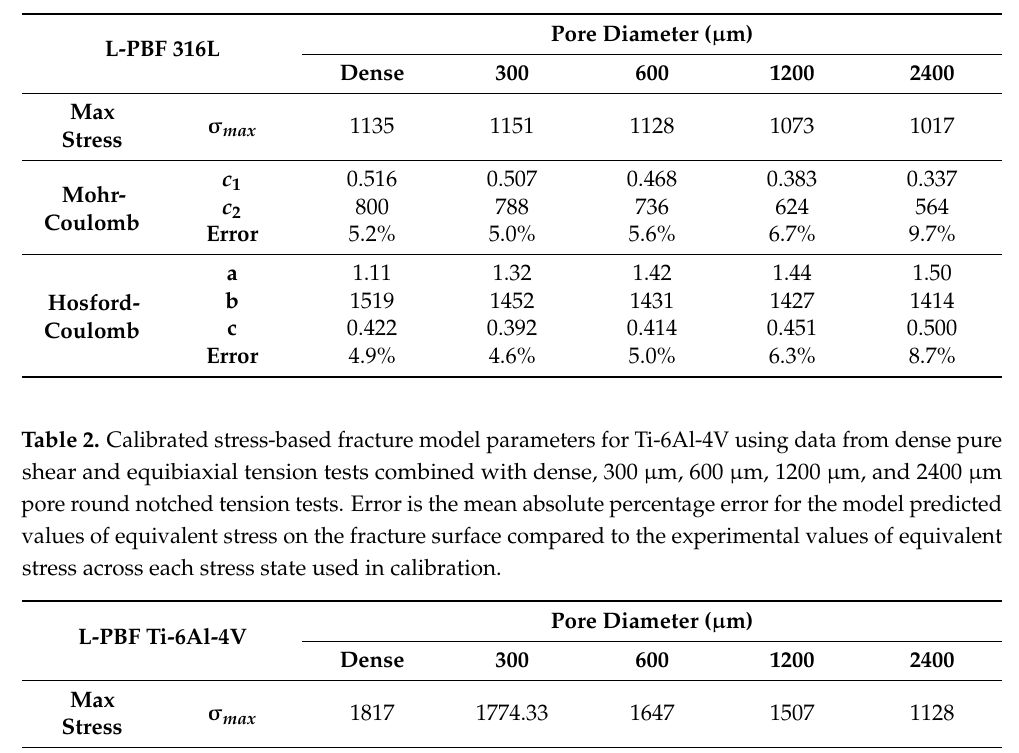
Table 1. Calibrated stress-based fracture model parameters for 316L using data from dense pure shear and equibiaxial tension tests combined with dense, 300 µ m, 600 µ m, 1200 µ m, and 2400 µ m pore round notched tension tests. Error is the mean absolute percentage error for the model predicted values of equivalent stress on the fracture surface compared to the experimental values of equivalent stress across each stress state used in calibration.